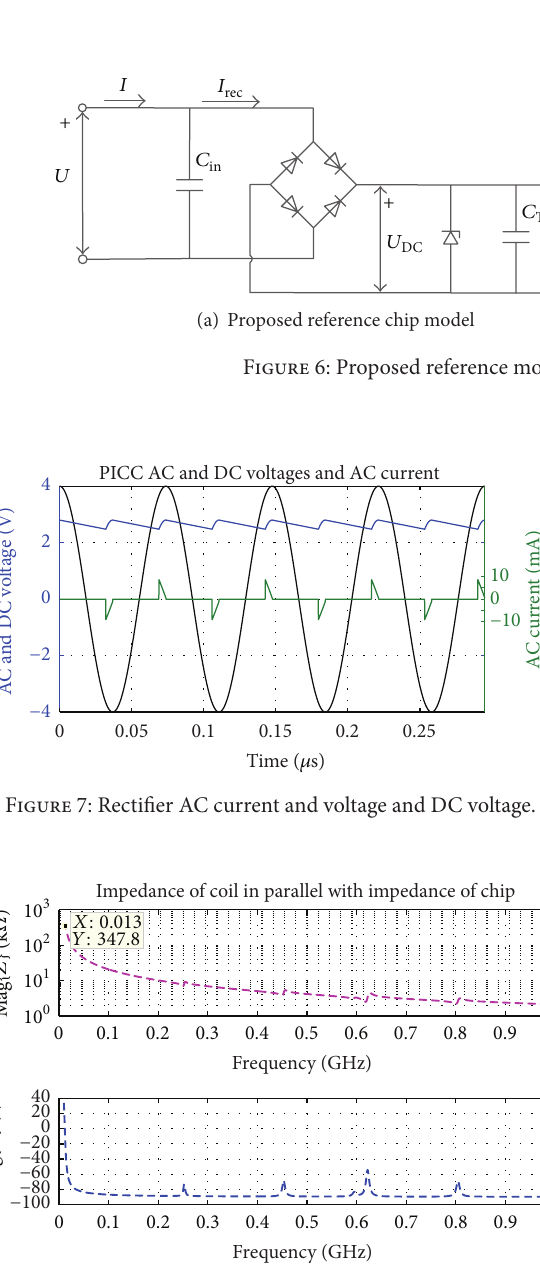
Figure 8: Equivalent PICC impedance (chip in parallel with